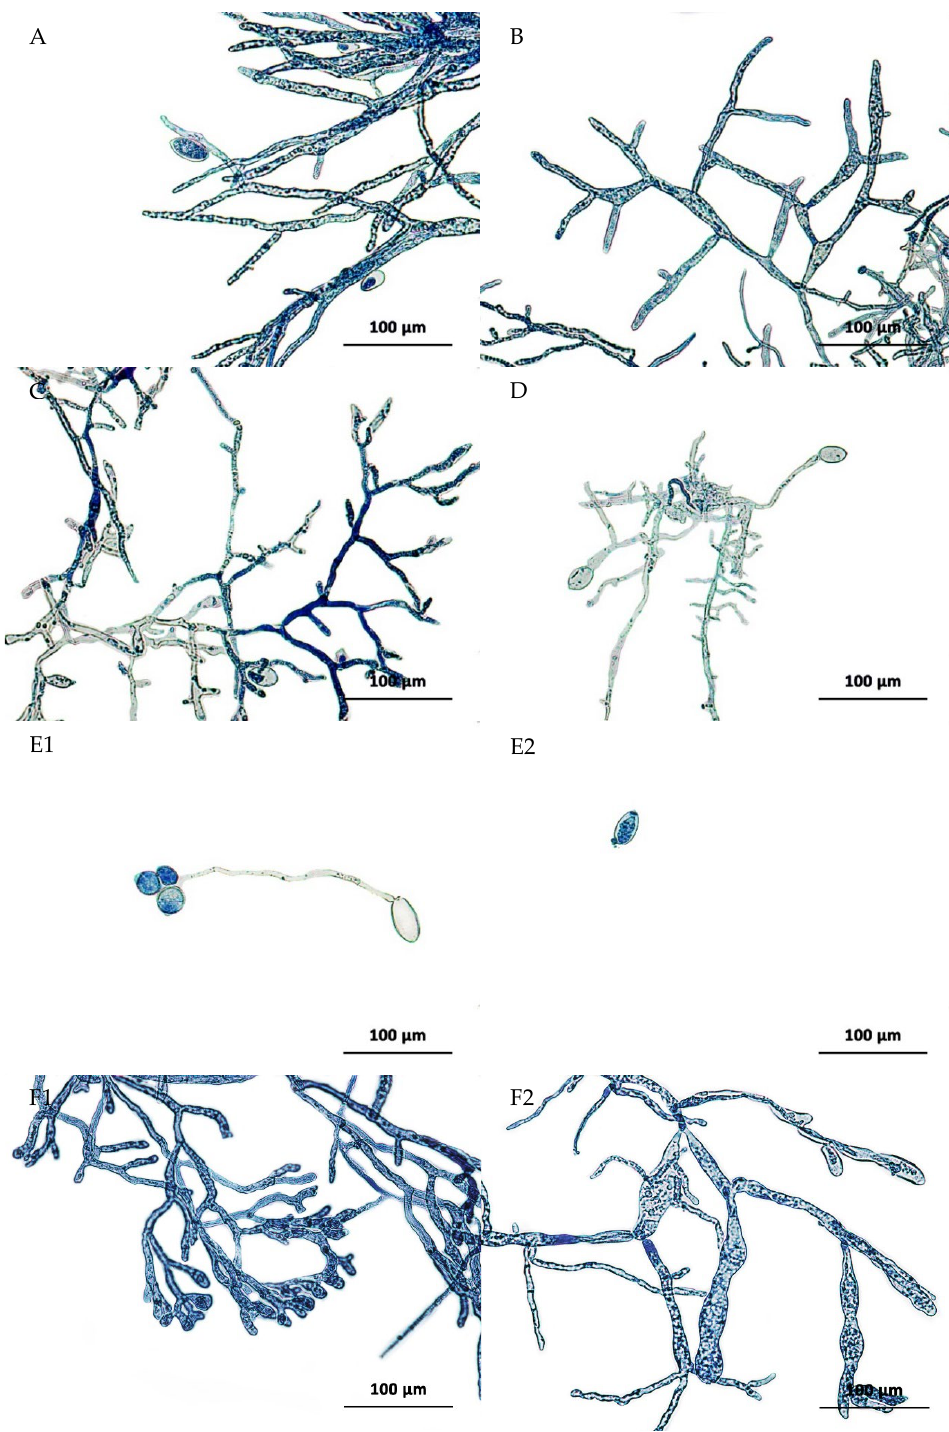
Figure 6. Optical microscopy images taken after 7 days of incubation of P. infestans in glucose peptone medium mixed with hop constituents and copper at concentrations close to their IC 50 . ( A ) Untreated control; ( B ) Illustration of branched mycelium; ( C ) Illustration of branched and partially lysed mycelium; ( D ) Illustration of lysed mycelium; ( E ) Germinated sporangia reforming sporangia (1) and non-germinated sporangia (2) under the DSE of leaves treatment; ( F ) Xanthohumol treatment leading to branched tips (1) and thick mycelium (2).